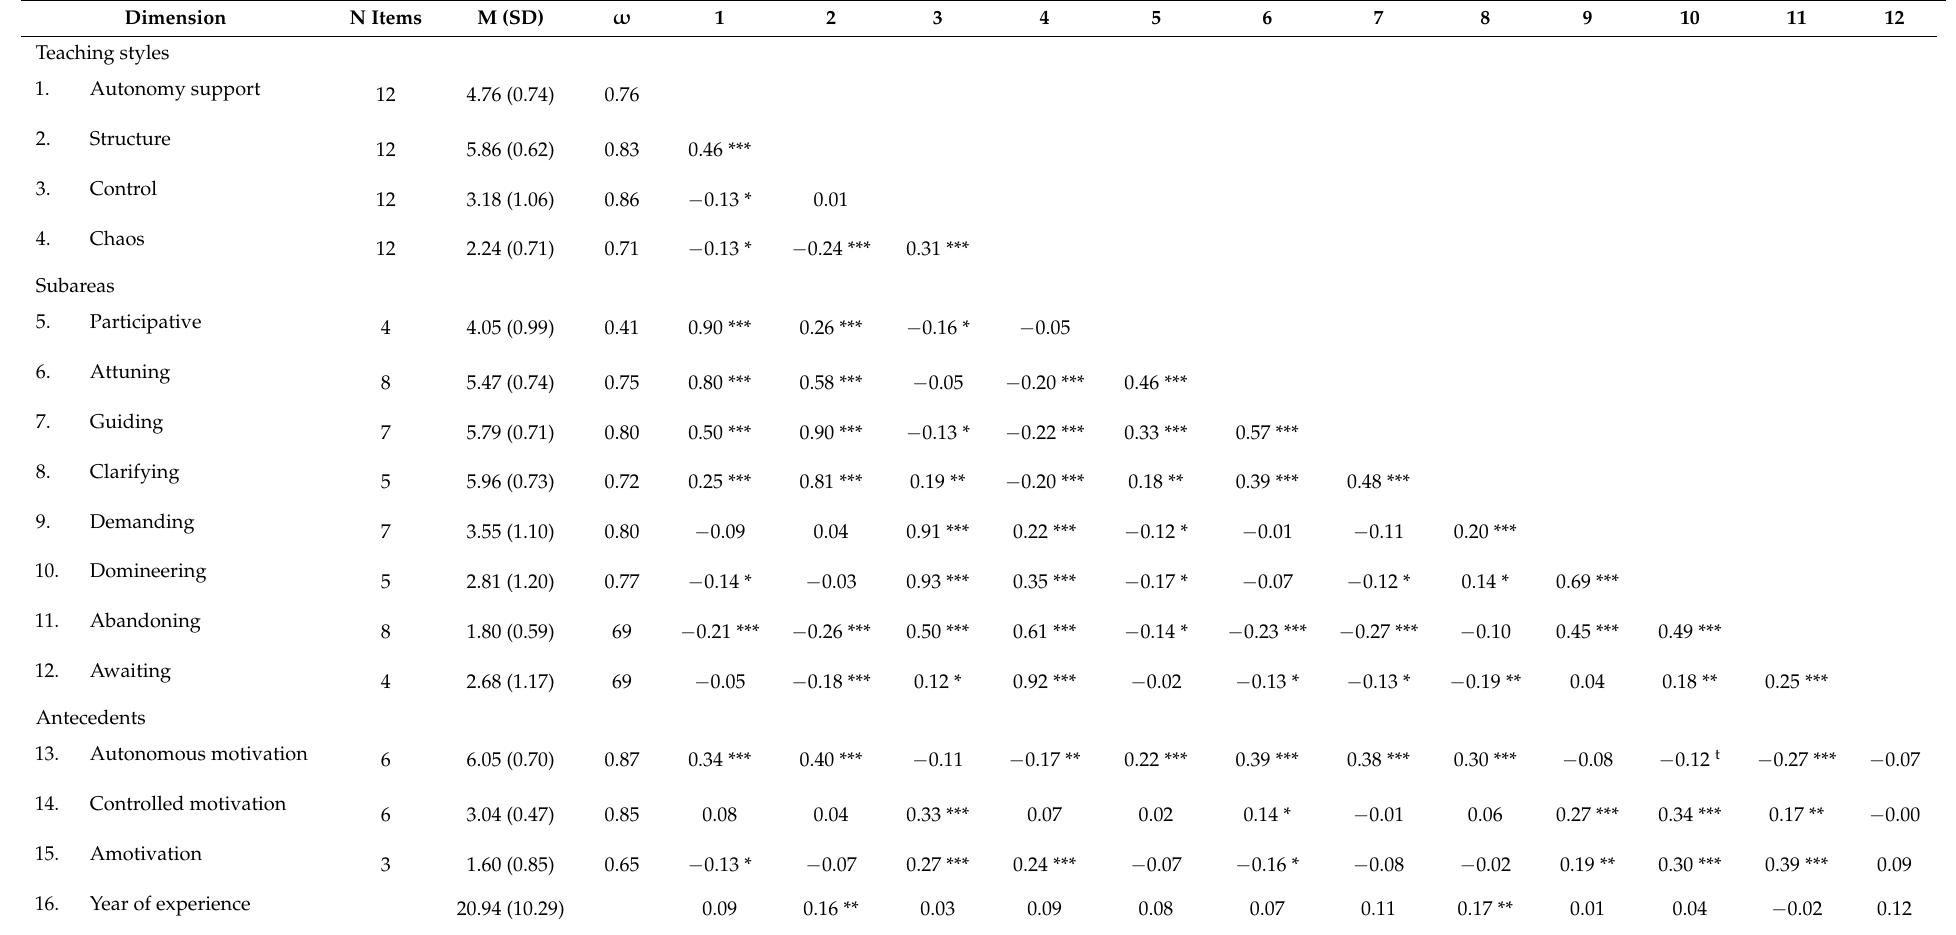
Table 5. Means, Reliabilities, and Correlations Among the Four Teaching Styles and Eight Identified Subareas in France (N =